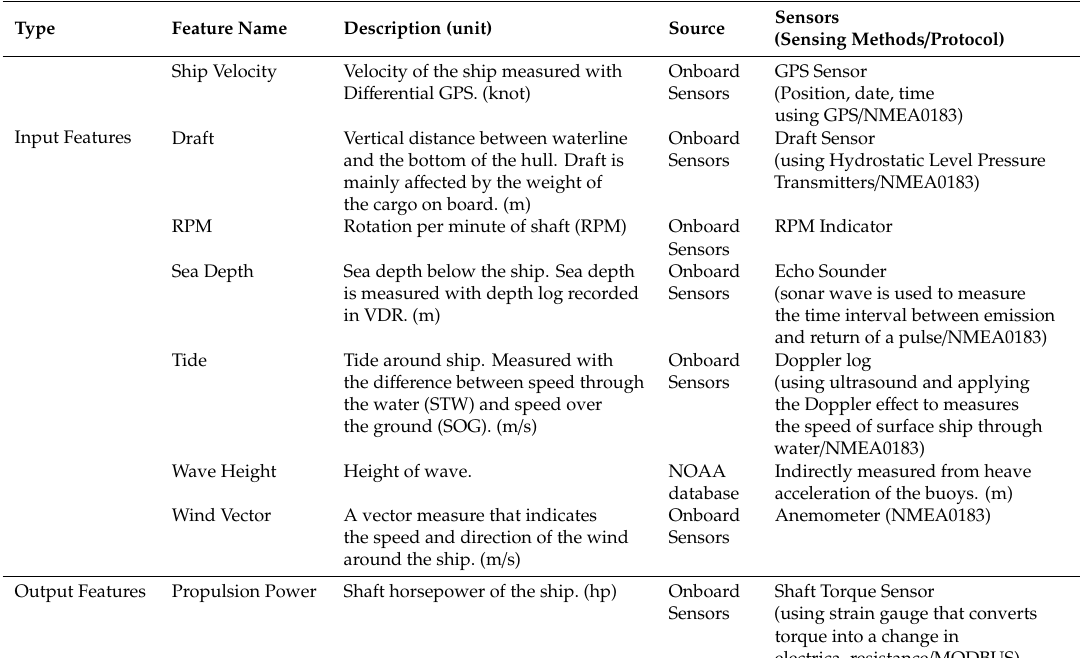
Table 2. Data feature